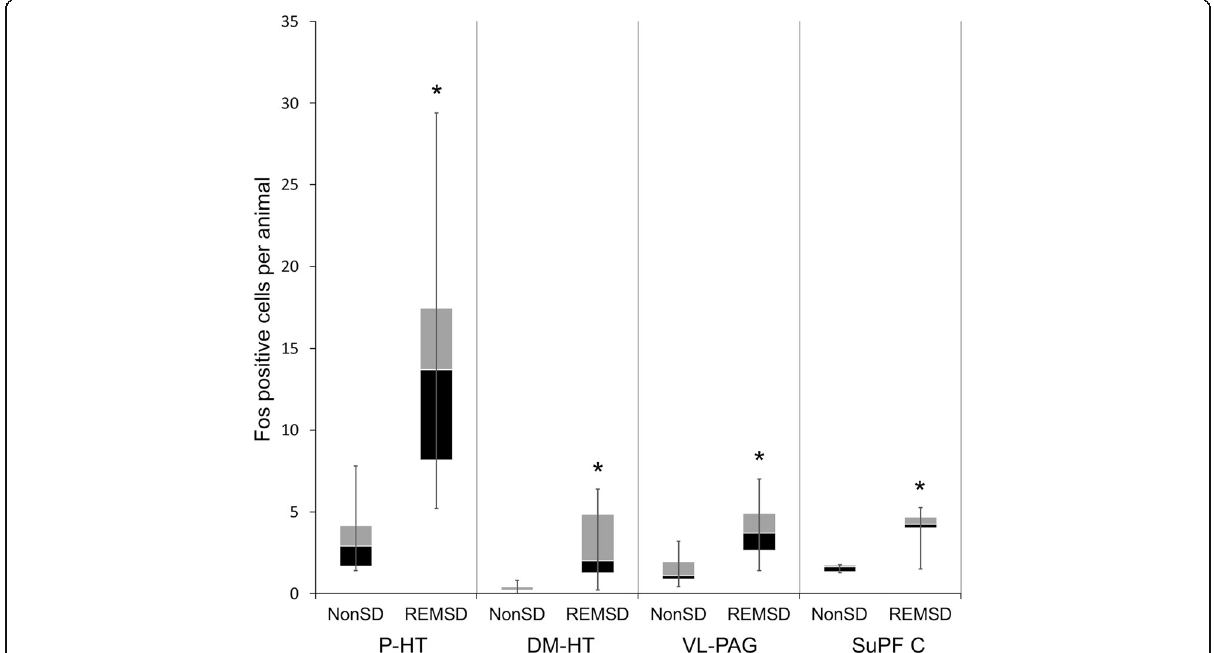
Fig. 3 Quantitative comparison of the number of Fos-positive cells per animal in the P-HT, DM-HT, VL-PAG, and superficial layer of the trigeminal nucleus caudalis in each group ( * indicates p < 0.05). Box plot displaying the median, 25th percentile (lower box), 75th percentile (upper box), and maximum to minimum range (whiskers)